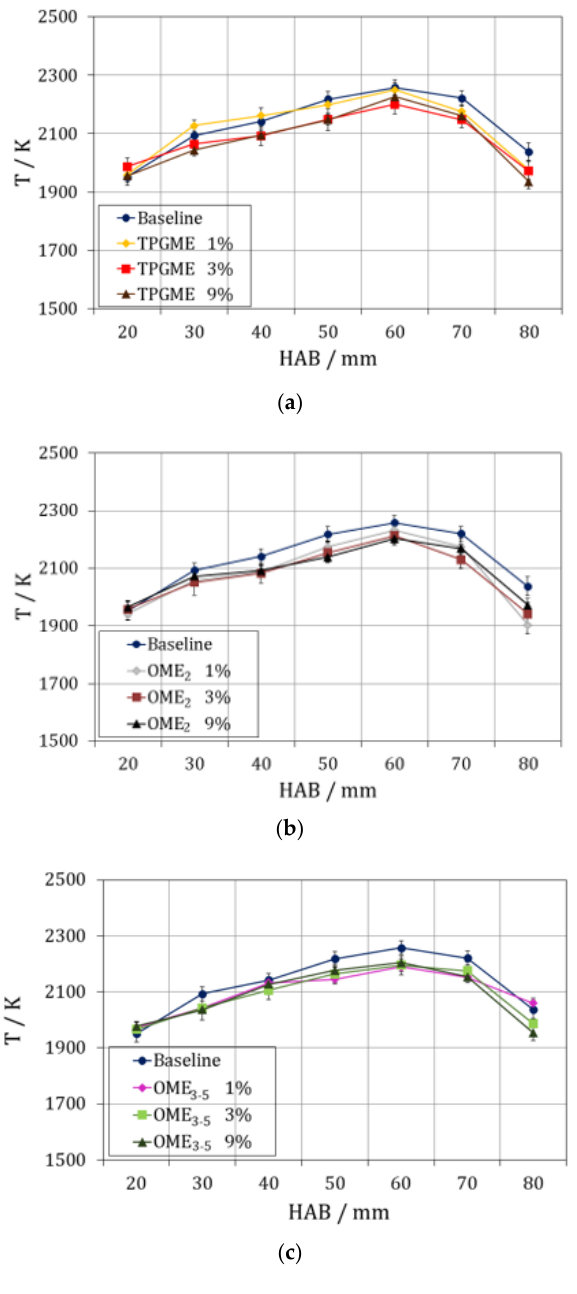
Figure 6. Vertical temperature trends for baseline and ( a ) TPGME–diesel blends (1% vol, 3%vol and 9% vol), ( b ) OME 2 –diesel blends (1% vol, 3% vol and 9% vol) and ( c ) OME 3–5 –diesel (1% vol, 3% vol and 9% vol). Error bars represent standard deviation of approx. 200 single-shot results.